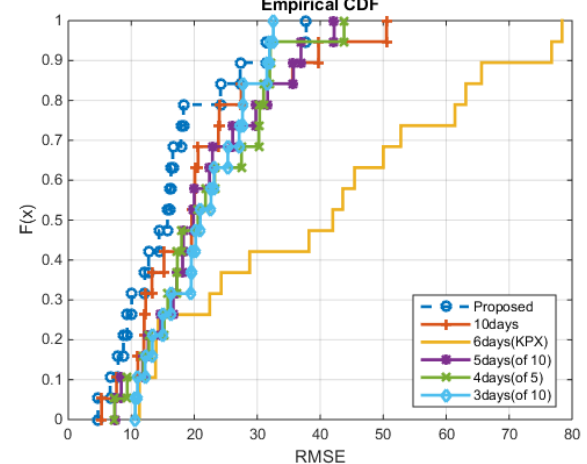
Figure 15. CDF evaluation of the proposed models in site B.